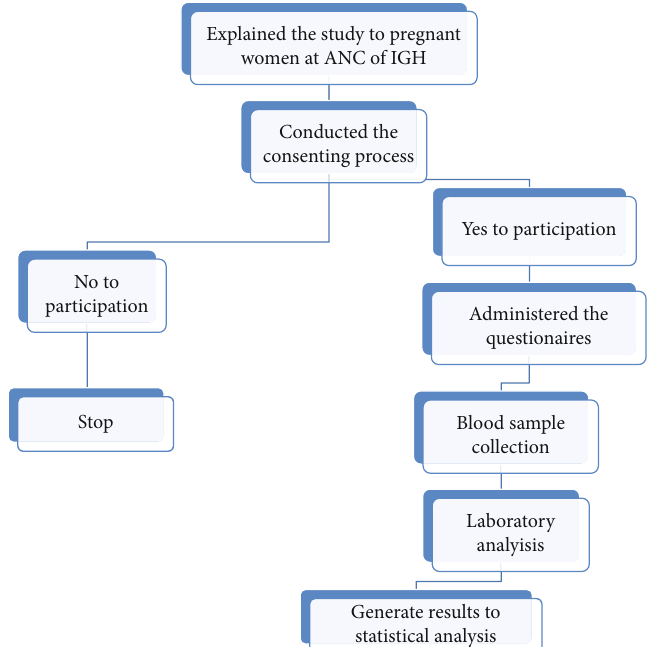
Figure 1: The fl ow of the study showing the sequence of the activities in the